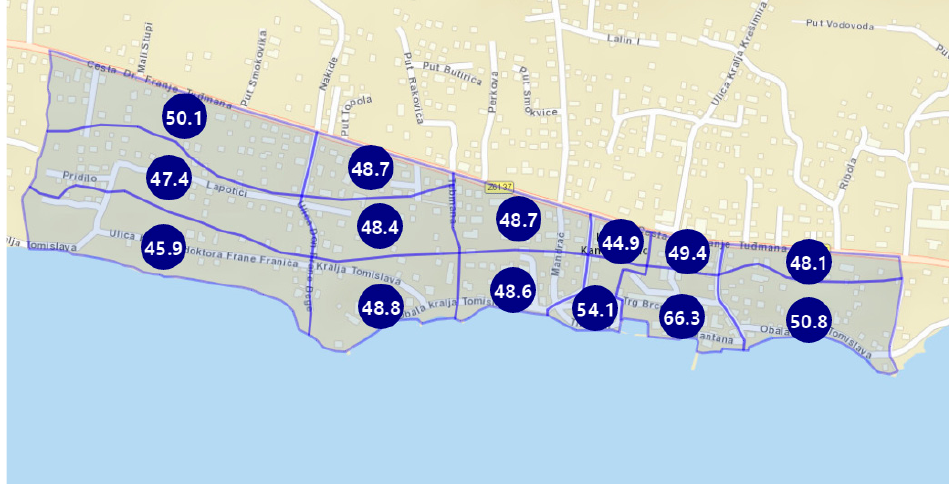
Figure 17. Results of risk analysis for seismic and flood hazard for Level 3 (Scenario S-F L3).